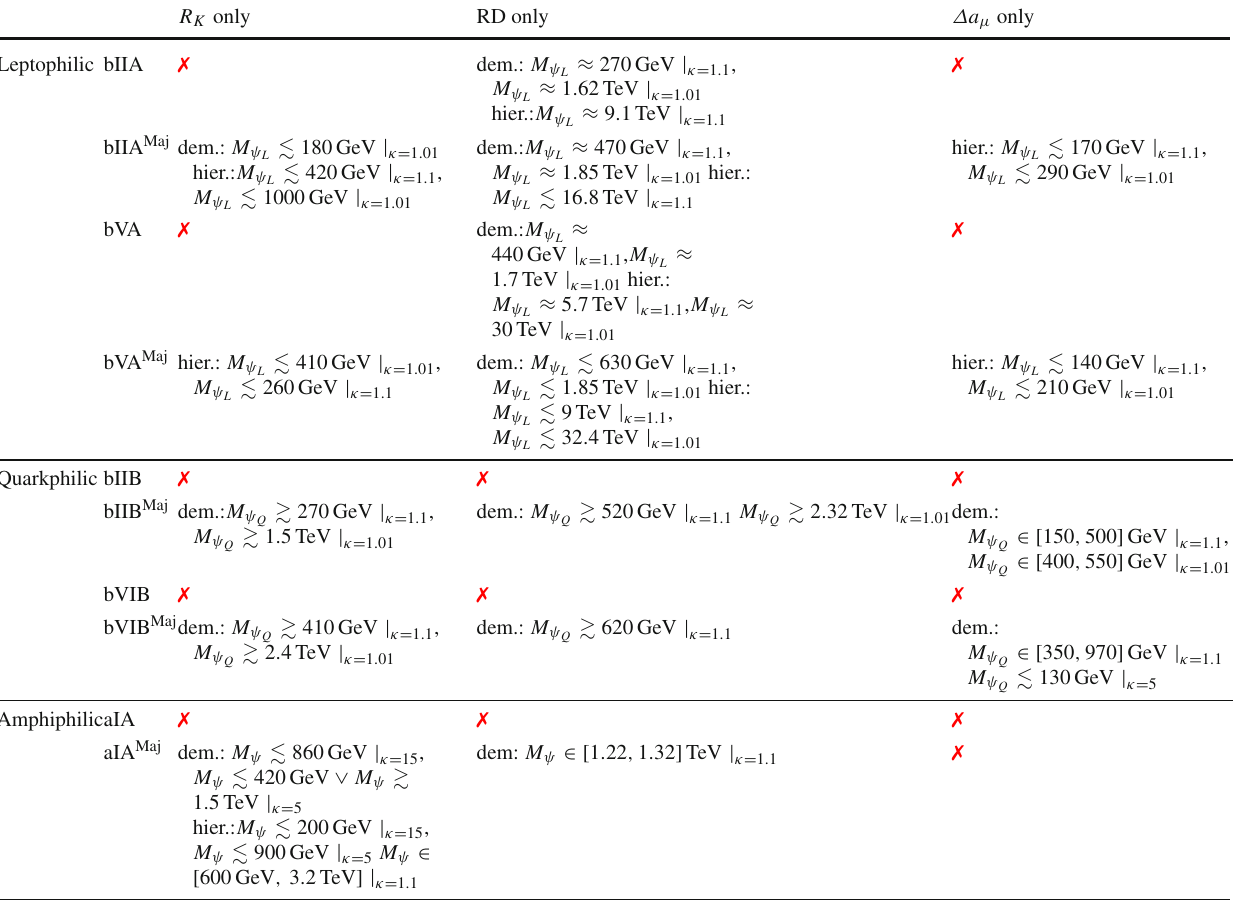
Table5 Welisttheviablemassregionsforvariousindividualsolutionstorelicdensity, R K and Δ a μ foreachmodelunderthepremiseofaccordance with direct detection limits R K only RD only Δ a μ only ≈ 270GeV | κ = Leptophilic bIIA ✗ dem.: M ψ 1 . 1 , L M ψ